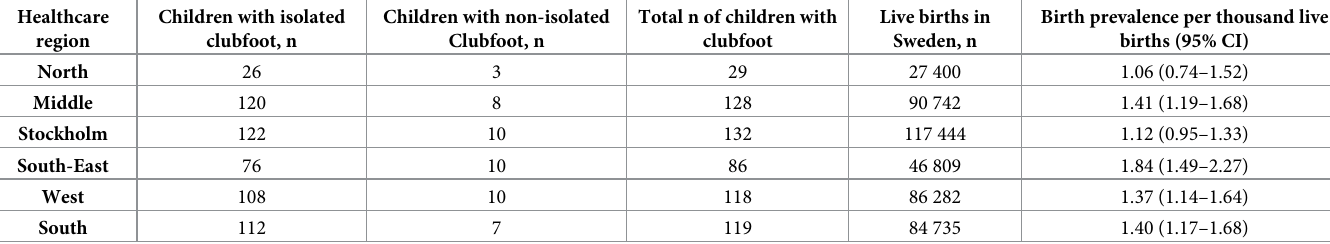
n, number of children; CI, confidence Interval. Live births refers to all children live born in Sweden from 2016 to 2109. The birth prevalence of clubfeet is based on the total number of children with clubfeet, including both isolated and